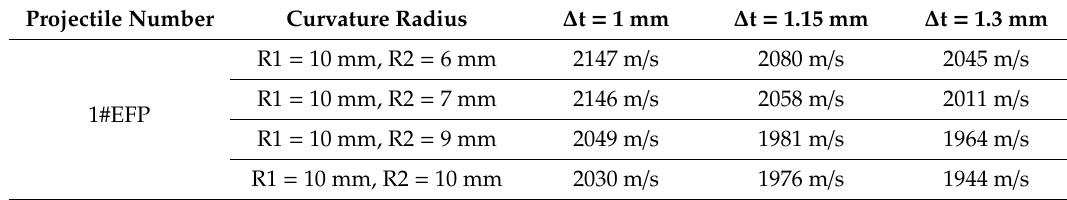
Table 7. 1#EFP-4#EFP formed